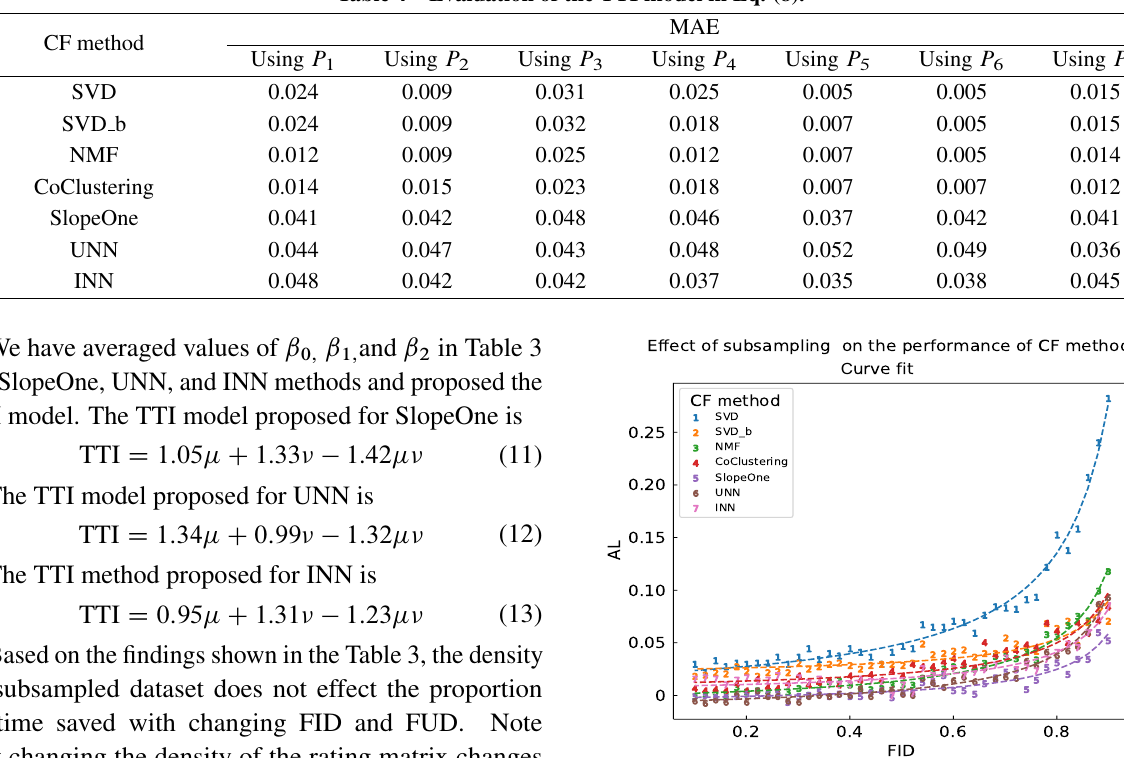
Table 4 Evaluation of the TTI model in Eq. (8).